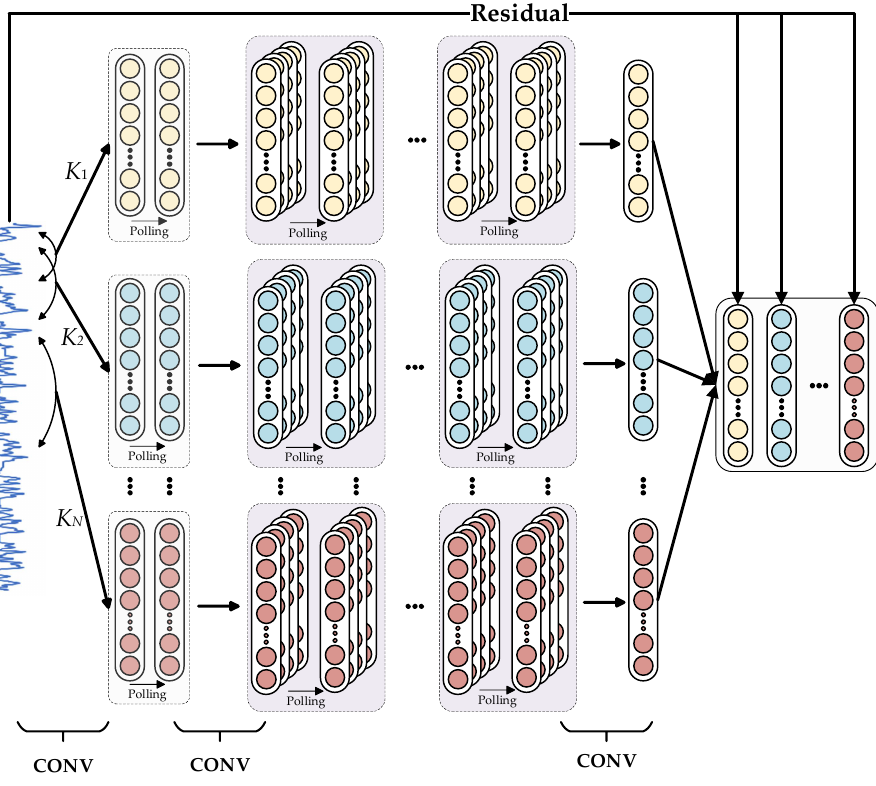
Figure 3. Multi-channel one-dimensional convolutional network.